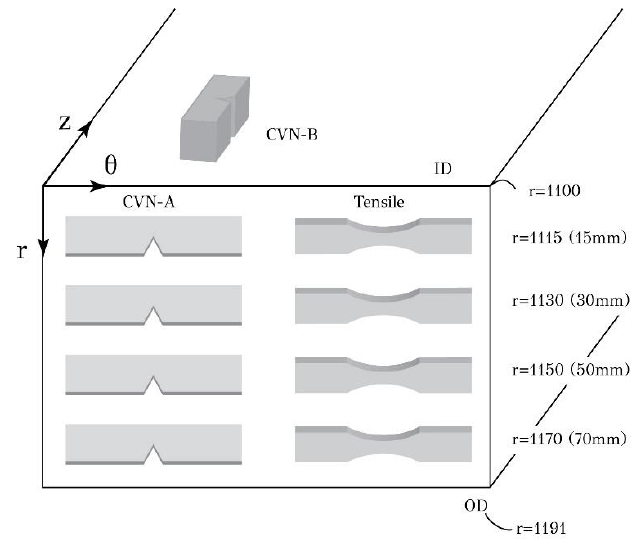
Figure 4. Positions of tensile specimens as well as Charpy-V-Notch, CVN-A and CVN-B specimens relative to ID and OD.